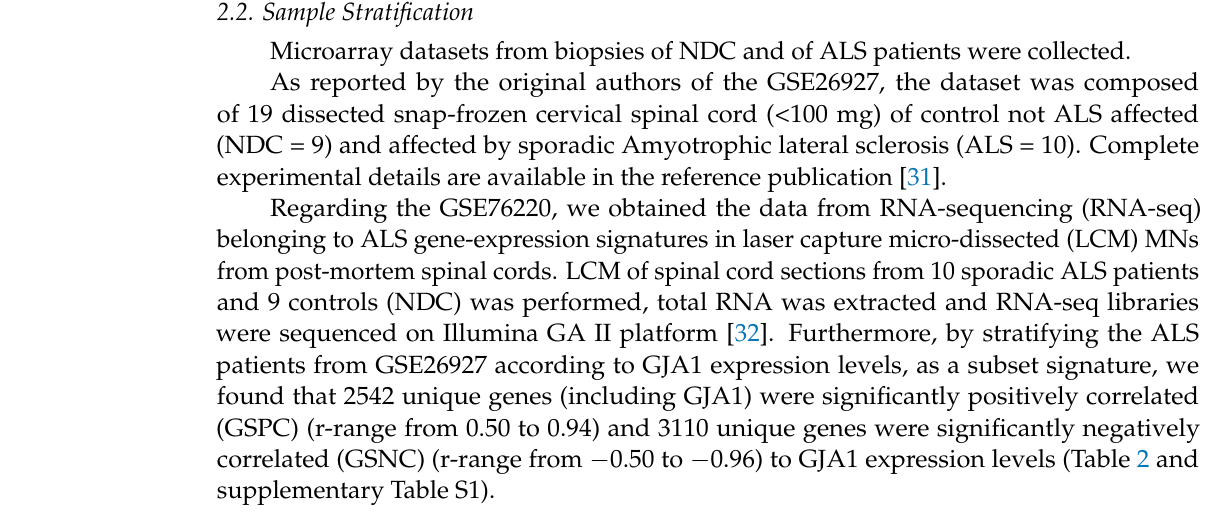
Table 2. Genes correlated to GJA1 in ALS